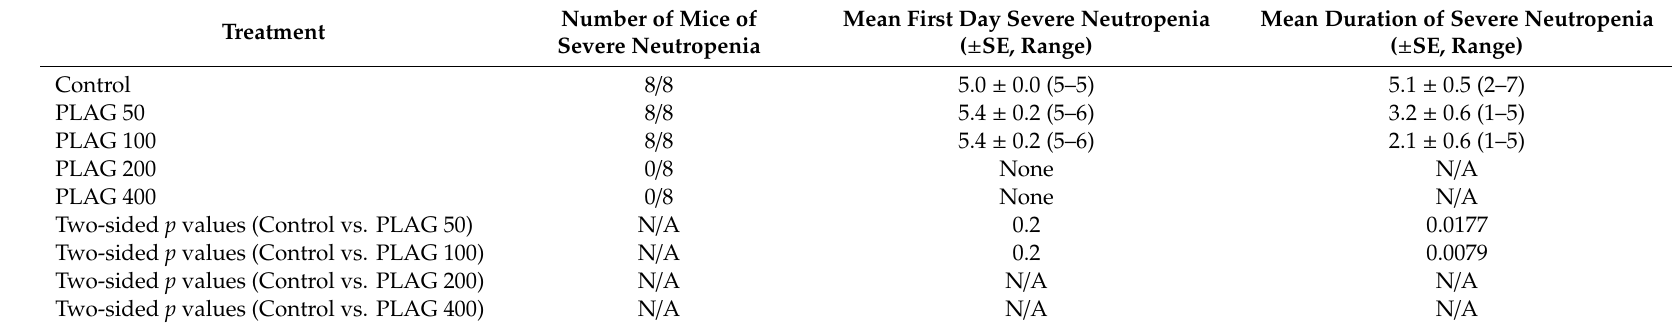
Table 2. Number of mice of severe neutropenia (ANC < 100 cells / µ L), and mean first day and mean duration of severe neutropenia in control and PLAG-treated mice injected with 5-FU (100 mg /